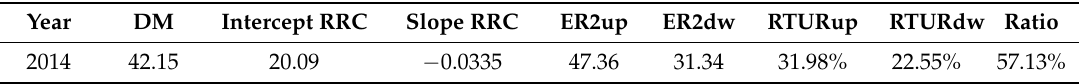
Table 2. Mean values of the electric power system data of the problem throughout 2014. Energy prices and intercept of the reserve curves are expressed in € /MW · h and € /MW, respectively. The slope of the reserve curves is expressed in €